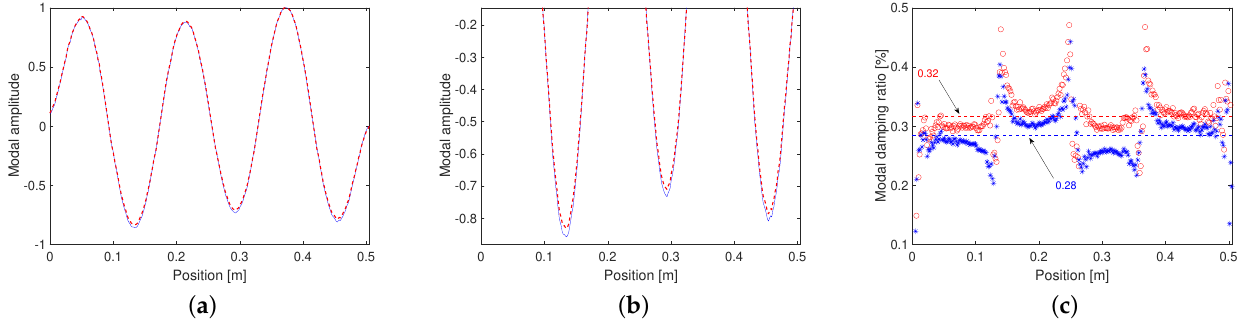
Figure 9. Comparison of the results obtained for the clamped–clamped beam with (red dash curves or circles) and without (blue curves or asterisks) the use of SVD for denoising: ( a , b ) mode shape of Mode 6 and ( c ) modal damping ratio of Mode